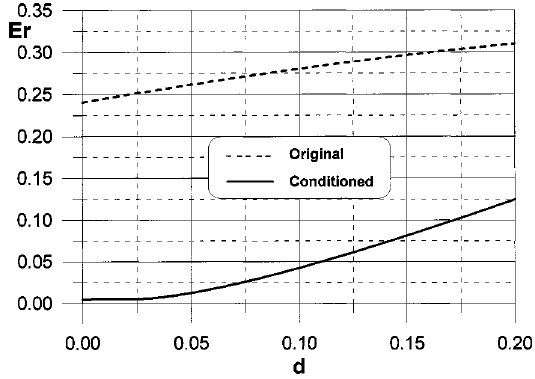
Fig. 15. Residual error function for variations of the dead band zone d .